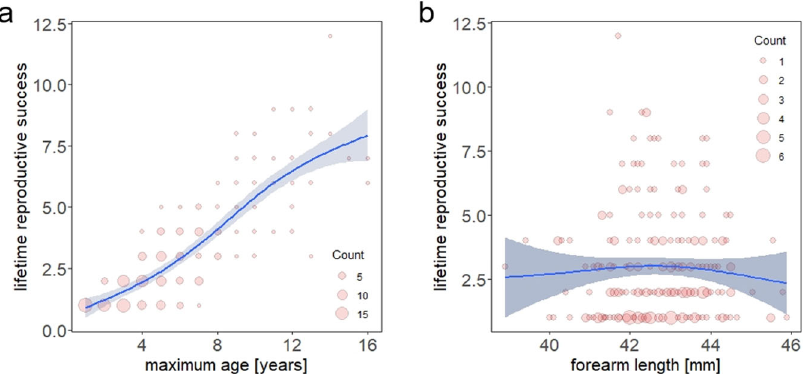
Fig. 3 In fl uence of longevity and size on individual fi tness. In fl uence of ( a ) longevity and ( b ) forearm length [mm] on the lifetime reproductive success, as smooth functions of a GAM ( k = 6, n = 225). Ninety- fi ve per cent con fi dence intervals are added. Count gives the number of overlapping data points.